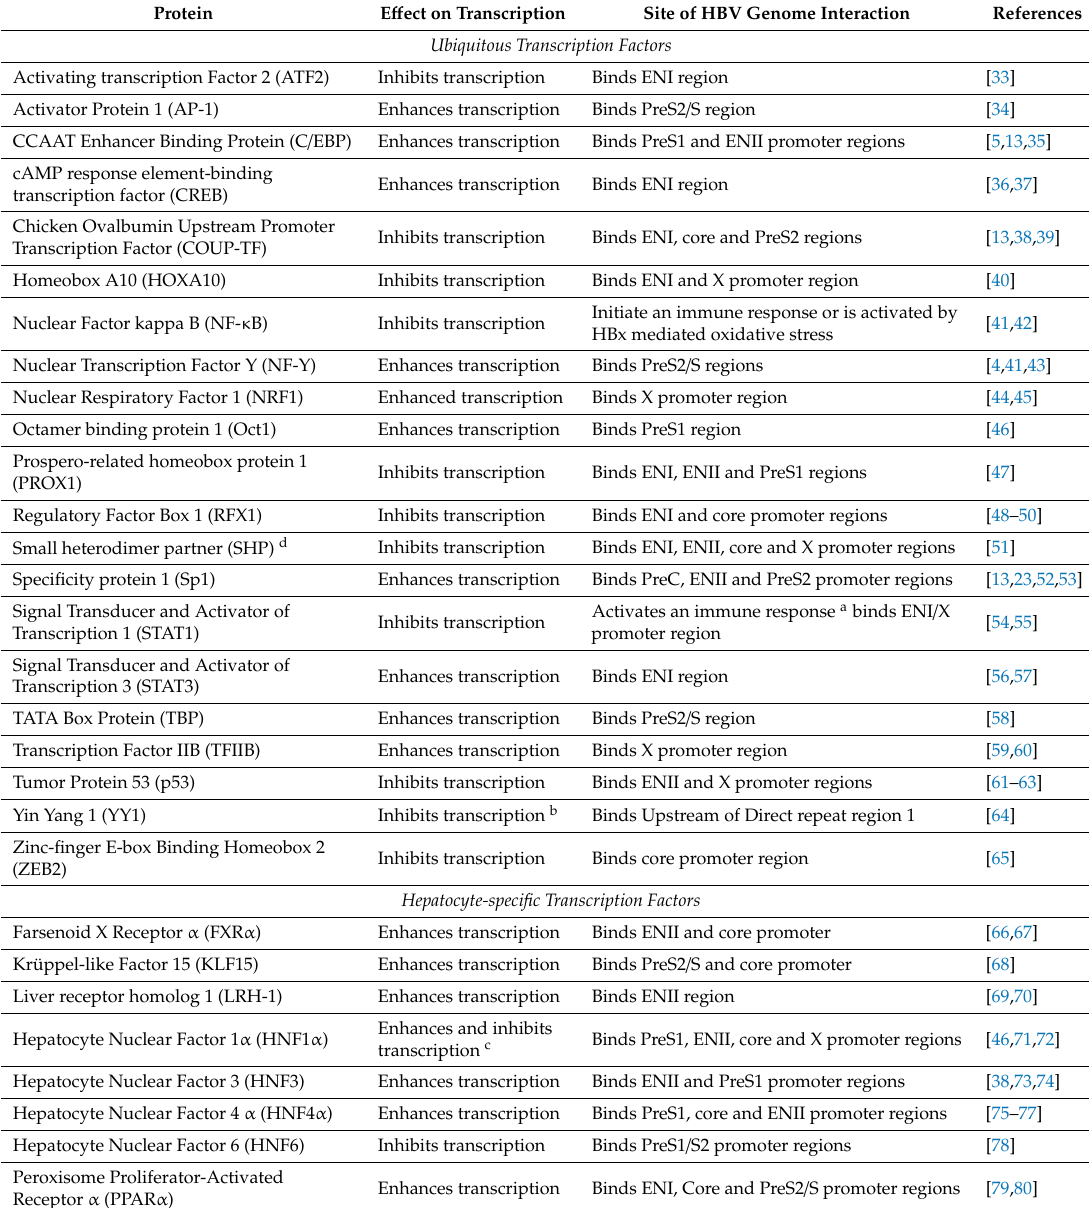
Table 1. A list of transcription factors and their e ff ect on viral replication. Protein E ff ect on Transcription Site of HBV Genome